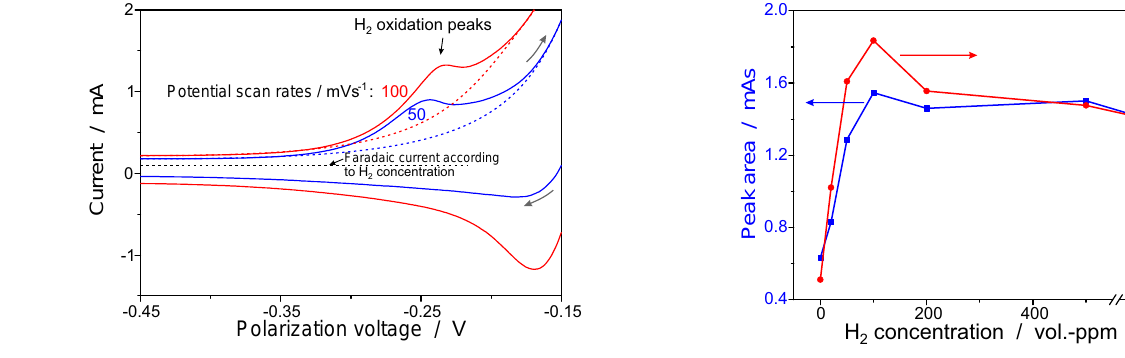
Figure 8. Heights and areas of the H 2 peaks from Fig. 7 depending on the H 2 concentration.